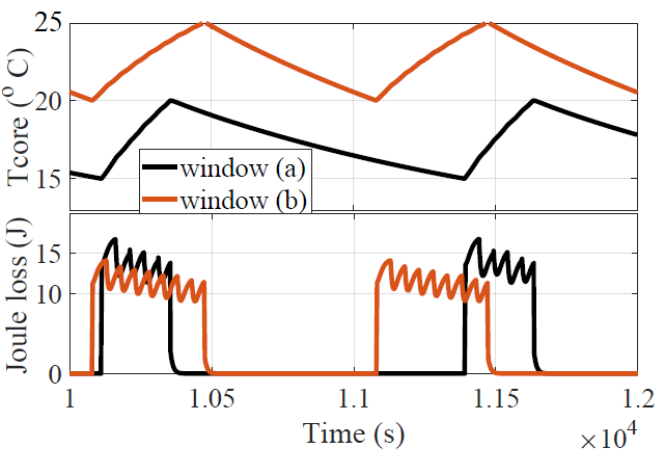
Figure 10. Internal heating temperature behavior and Joule losses on the NMC core at 10 ◦ C ambient temperature and for two different cases: temperature window ( a ) 15 ◦ C to 20 ◦ C; and temperature window ( b ) 20 ◦ C to 25 ◦ C.